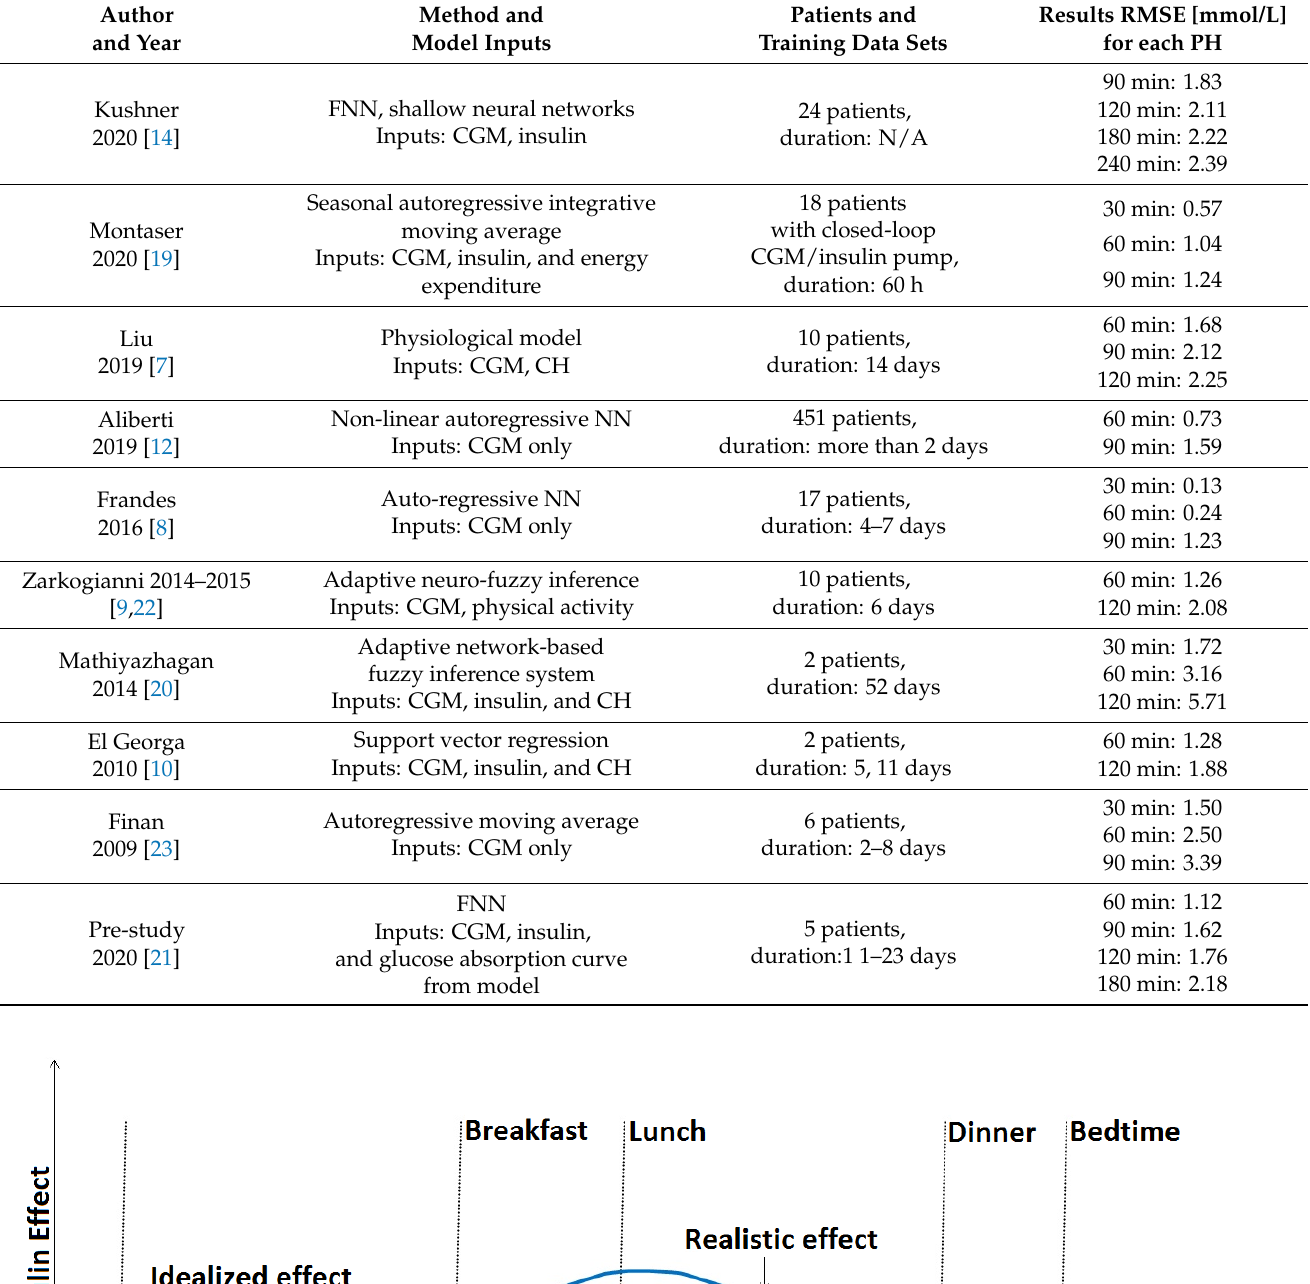
Table 1. Recent results on high blood glucose level (BGL) prediction models on real patients, for 60 min or longer prediction horizons (PHs). Authors’ previous study in italics at the bottom. N/A: no data available.